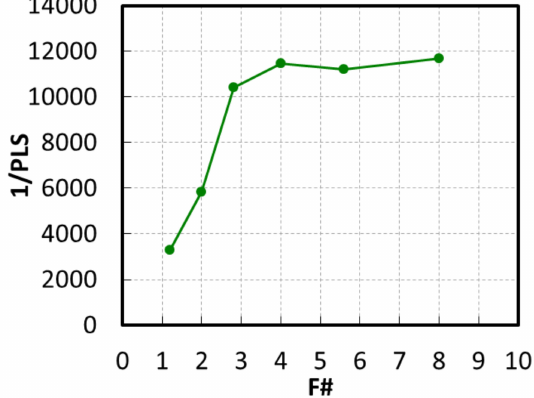
Figure 15. F# dependence of 1 / PLS with a green pixel.